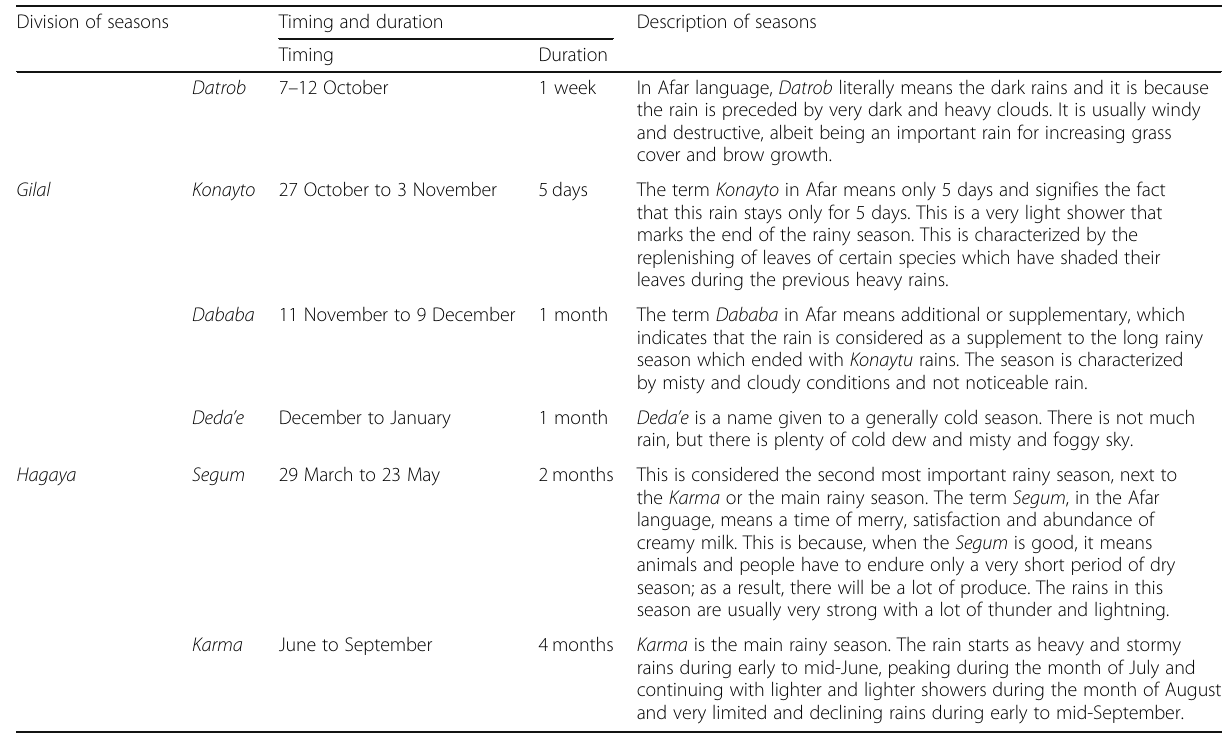
Table 1 Traditional Afar rain calendar and description of seasons Division of